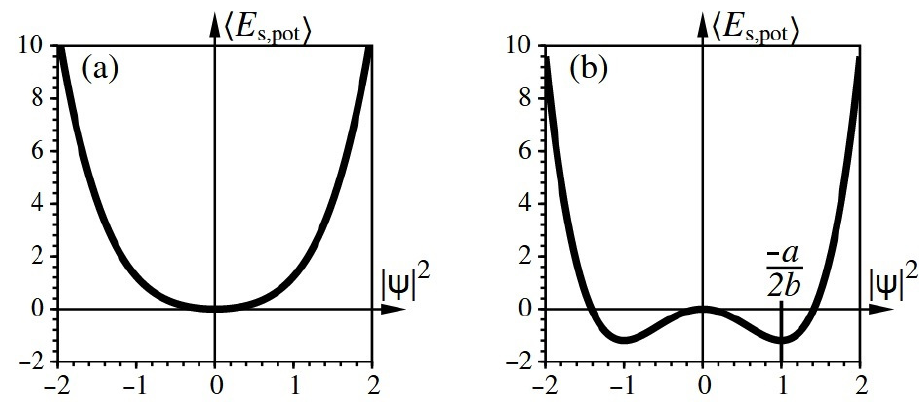
Figure 4. Function (cid:104) E (cid:105) versus | ψ | 2 = ρ s : ( a ) the parameter a > 0; ( b ) the parameter a < 0. The point − a / ( 2 b ) is position of energy minimum of the function (cid:104) E s,pot (cid:105) written out in Equation (91).